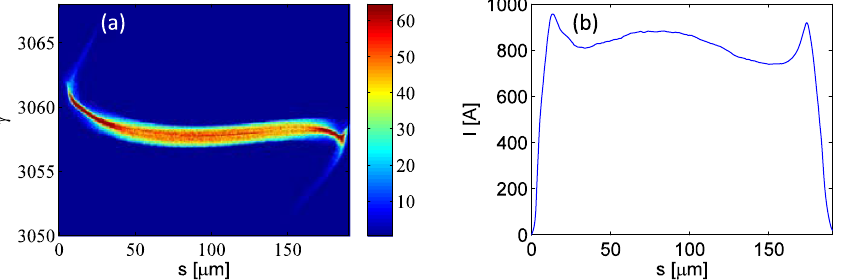
FIG. 6. Simulation results for (a) the longitudinal phase and (b) current profile of the electron beam at the entrance of the HB-HGHG scheme.